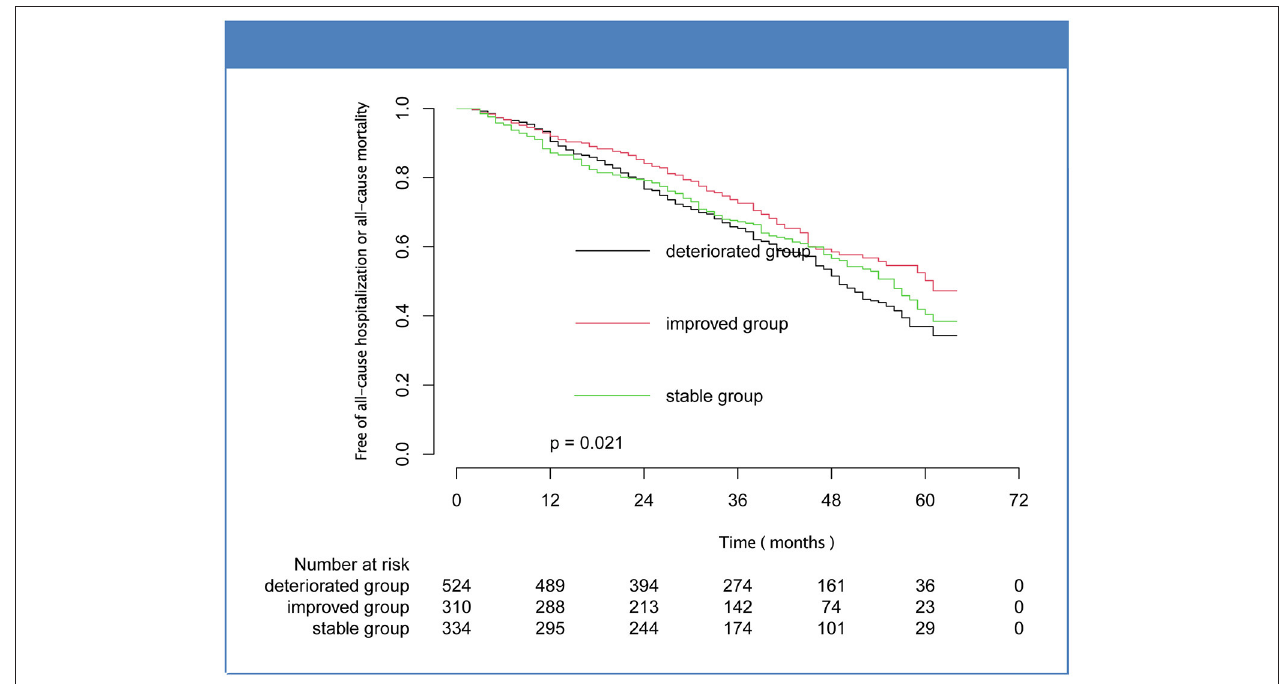
FIGURE 3 | Kaplan-Meier curves for composite outcome of mortality or hospitalization for the subsets of heart failure with midrange ejection fraction.